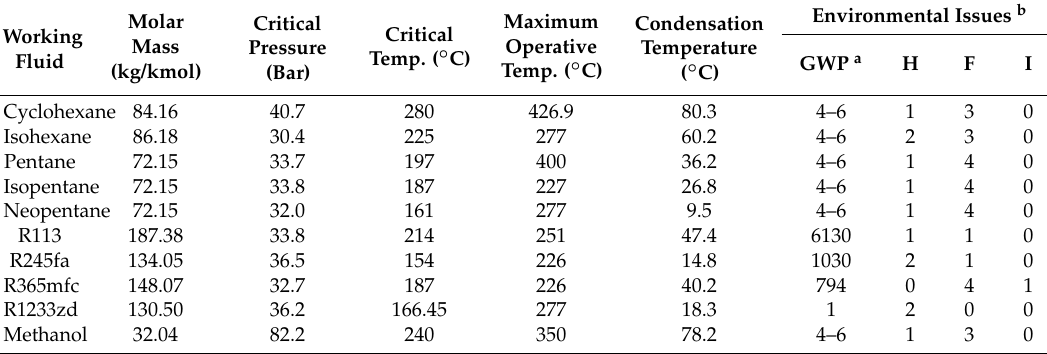
Table 4. Physical and environmental properties of the suitable working fluids. Working